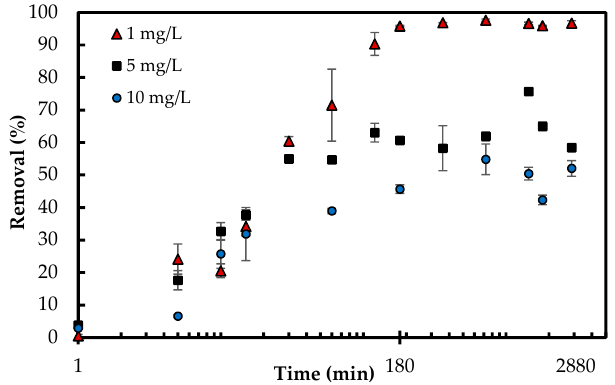
Figure 6. Effect of contact time on phosphate removal percentage (Experimental conditions: 0.5 g/L Zn(II)–CTS dose; 1, 5 and 10 mg/L initial phosphate concentration; pH 4).